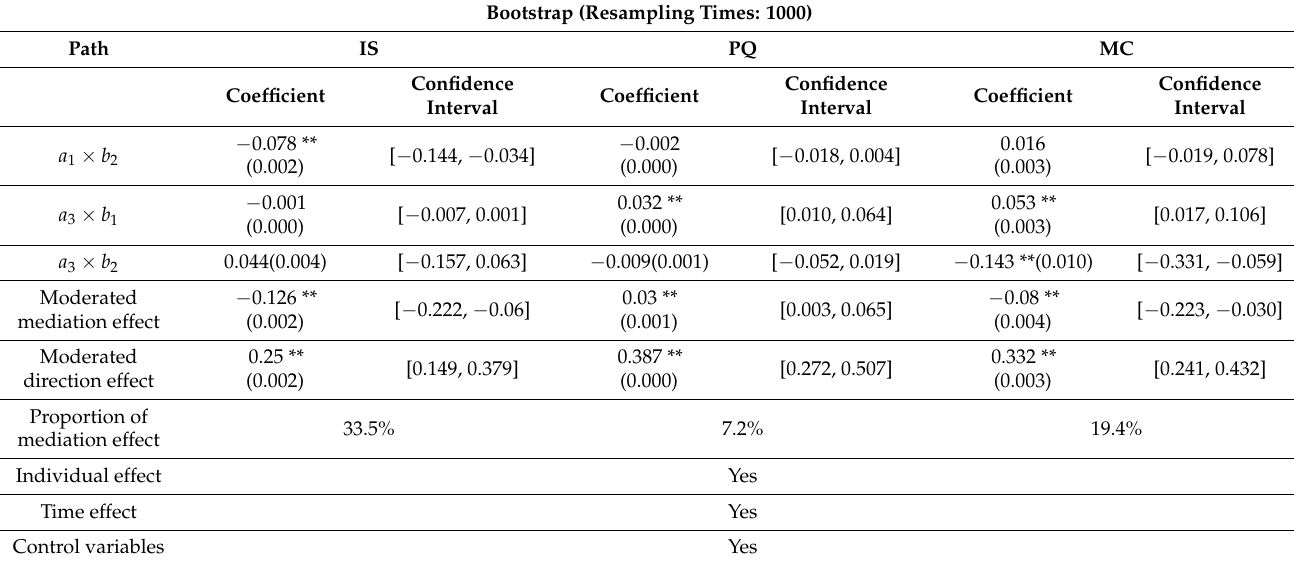
Table 8. Product test of moderated mediation effect of digital economy.